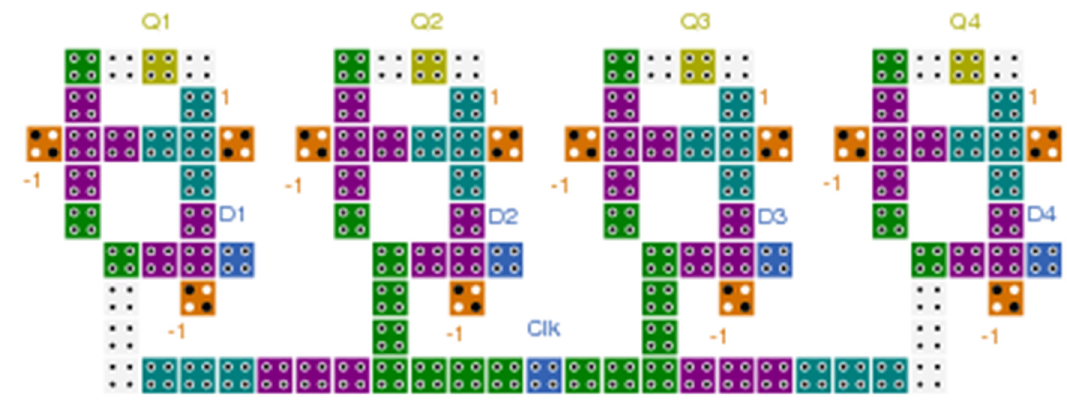
Figure 13. QCA Implementation of 4-bit PIPO shift register.